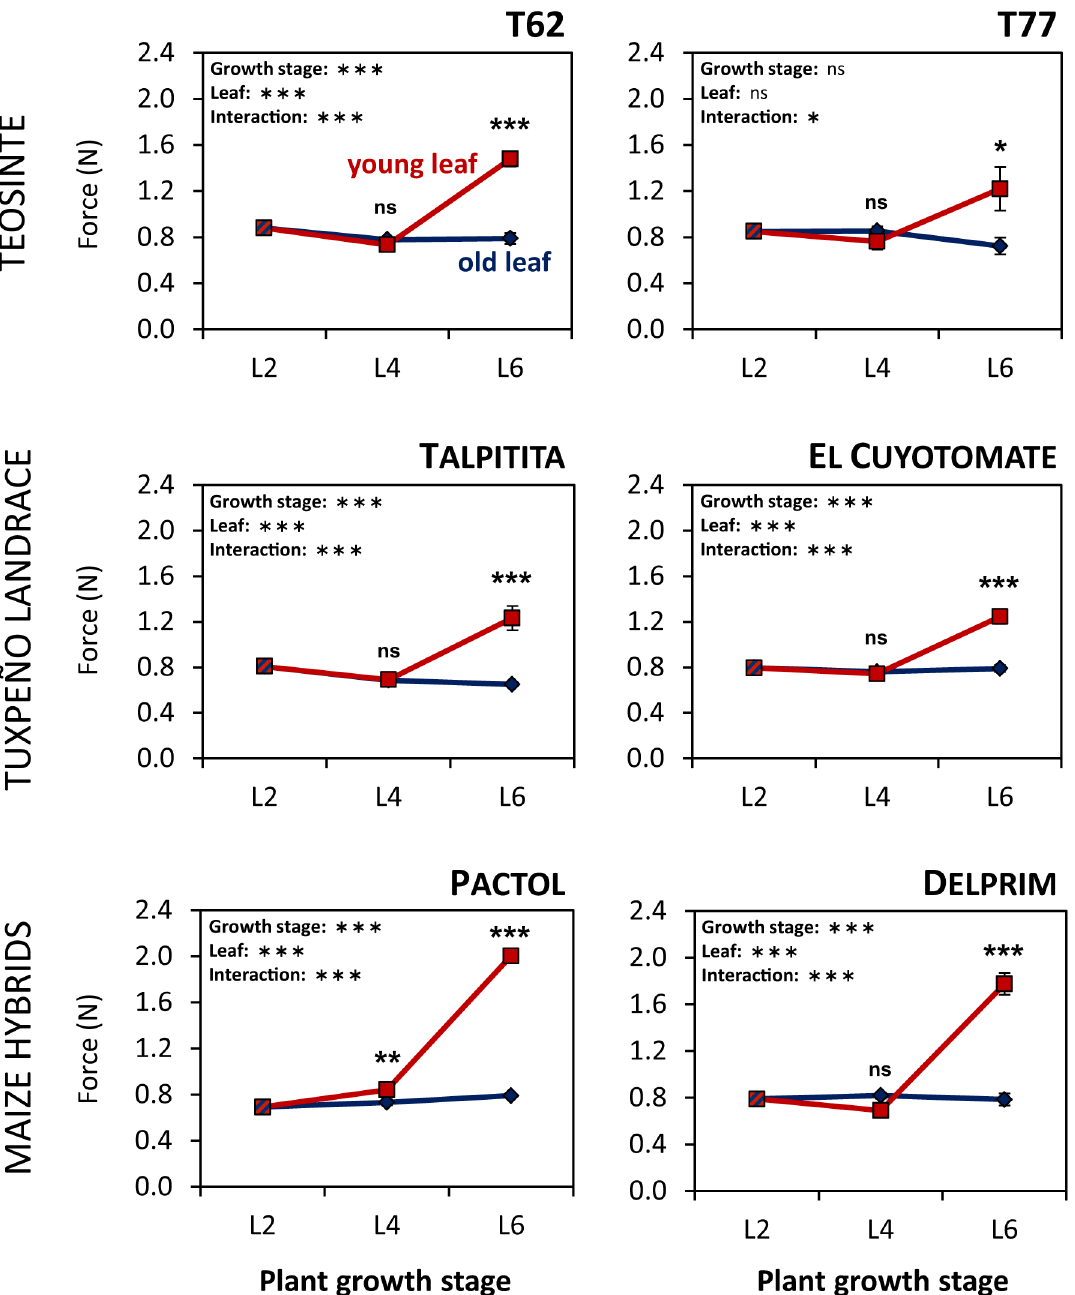
Fig 4. Leaf toughness in maize and teosinte increases in a leaf-specific manner during early ontogeny. Leaf toughness was measured in old (blue) and young (red) leaves of two teosinte accessions (T62 and T77), a Tuxpe ñ o landrace variety from two collection sites (Talpitita and El Cuyotomate) and two maize hybrid lines (Pactol and Delprim) at three early vegetative growth stages (L2, L4 and L6). Leaf toughness is expressed as the force needed for penetration of the leaf blade and given in Newton (N) (mean ± SE; N = 3 – 5). Statistically significant effects of plant growth stage or leaf identity on leaf toughness are denoted by asterisks ( * P < 0.05; ** P < 0.01; *** P < 0.001, ns: not significant; two-way ANOVA without growth stage